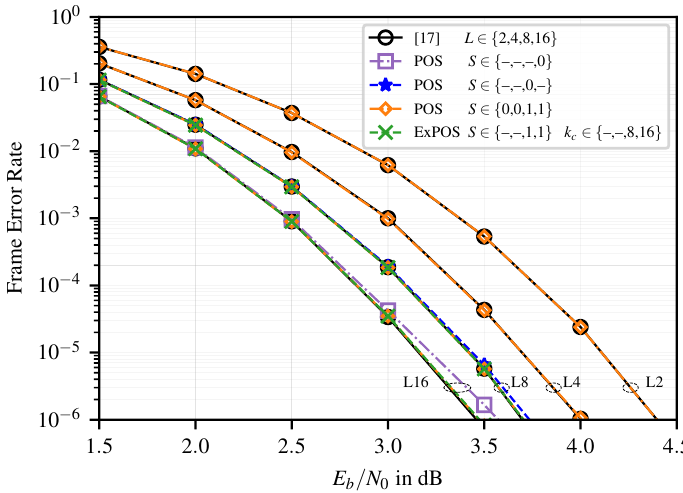
Figure 9. Error-correction performance of Polar code N = 1024, R =